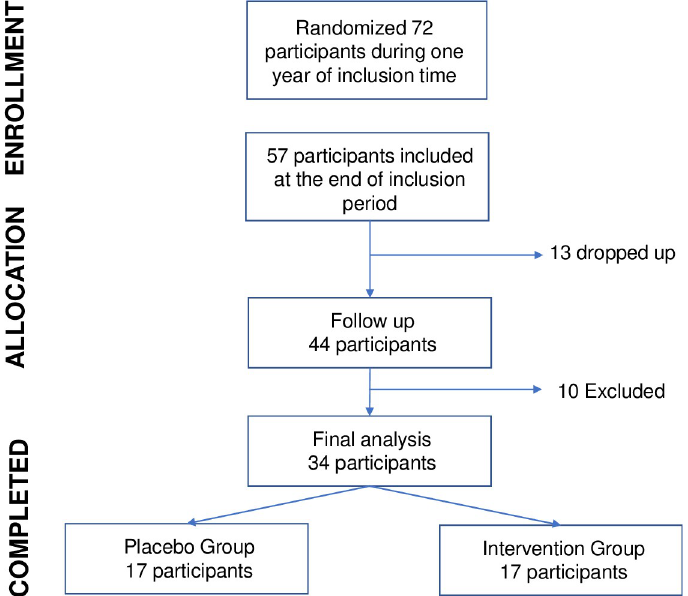
Fig 1. Trial enrollment profile. In total, 72 women with menopause were randomized during inclusion time period, 57 met the inclusion criteria and were enrolled in the study. Some participants resigned and others were excluded from the trial for various reasons (see flow diagram for